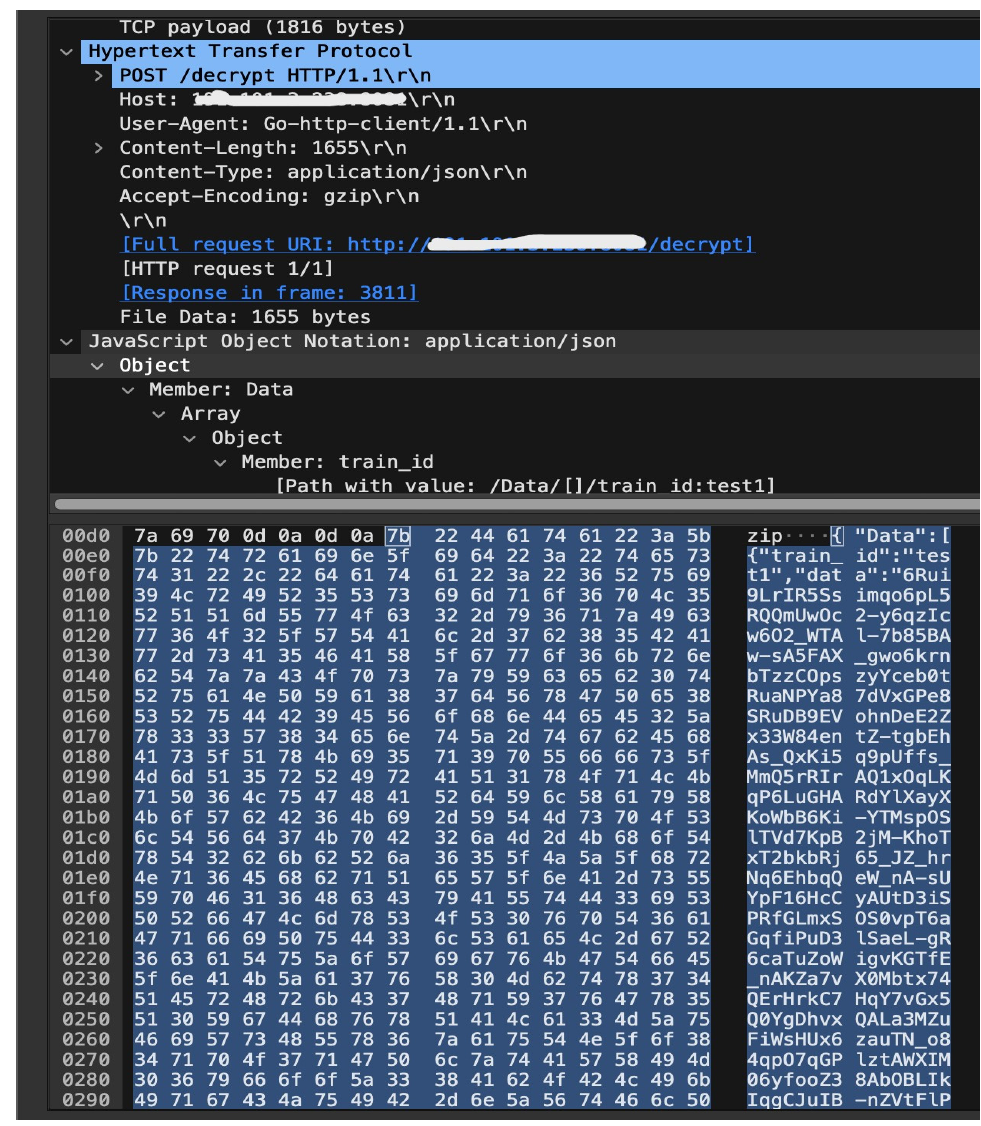
Figure 10. Secured unreadable data from eavesdrop attack on secure TCMS.